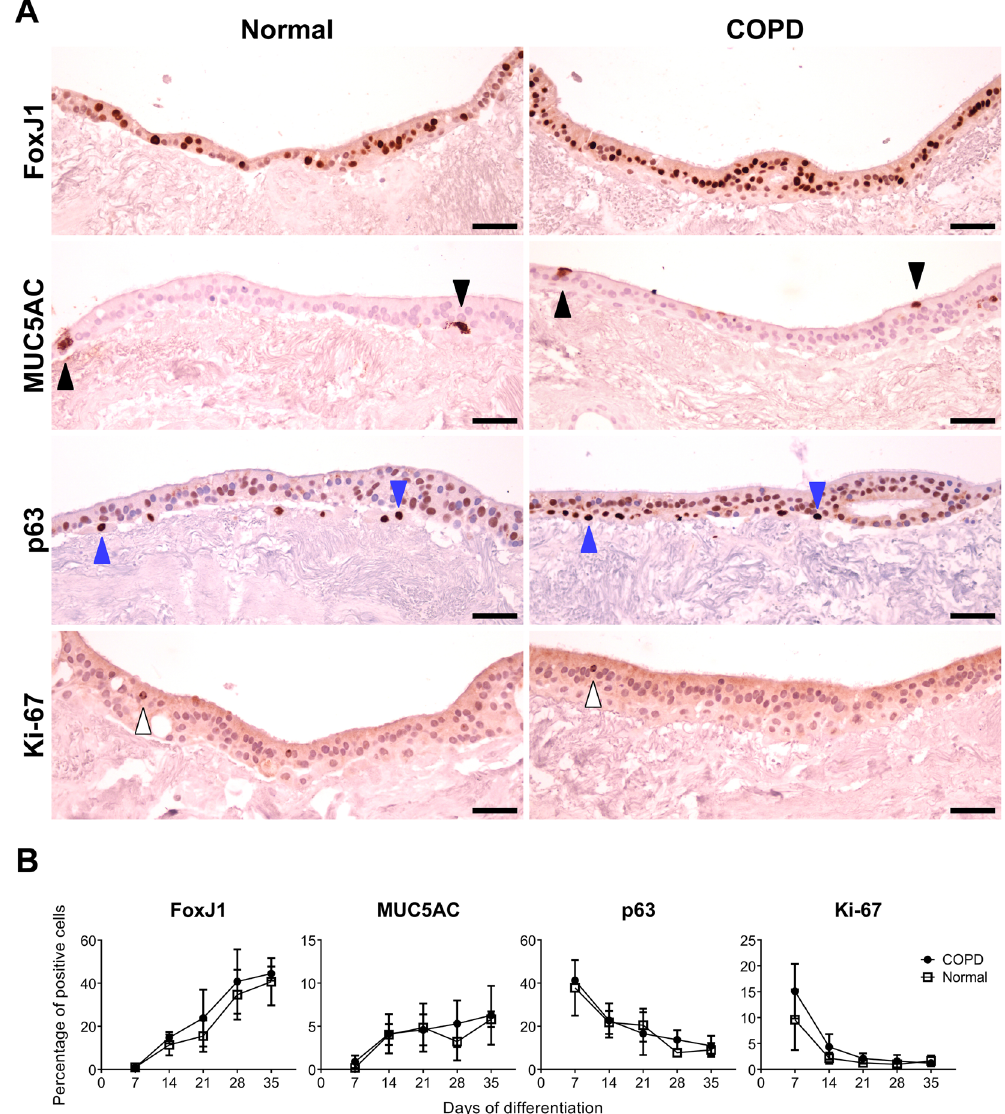
Figure 4. Primary normal human bronchial epithelial cells differentiate into airway epithelium on normal and COPD bronchial scaffolds. ( A ) Primary normal human bronchial epithelial cells immunostained for FoxJ1 (ciliated cells), MUC5AC (mucin 5AC) (goblet cells), p63 (basal cells) and Ki-67 (proliferation marker) after 35 days of differentiation on normal or COPD human bronchial scaffolds. Images are representative of n = 3. ( B ) Percentages of positive cells for each marker during differentiation were calculated using image analysis of immunohistochemistry results (n = 3) and counterstaining with hematoxylin allowed for counting of the total number of cells. Data were analyzed with two-way ANOVA tests using Sidak correction and graphs indicate mean and standard deviation. Black arrows: goblet cells. Blue arrows: basal cells. White arrows: Ki-67 positive cells. Scale bars: 50 µ